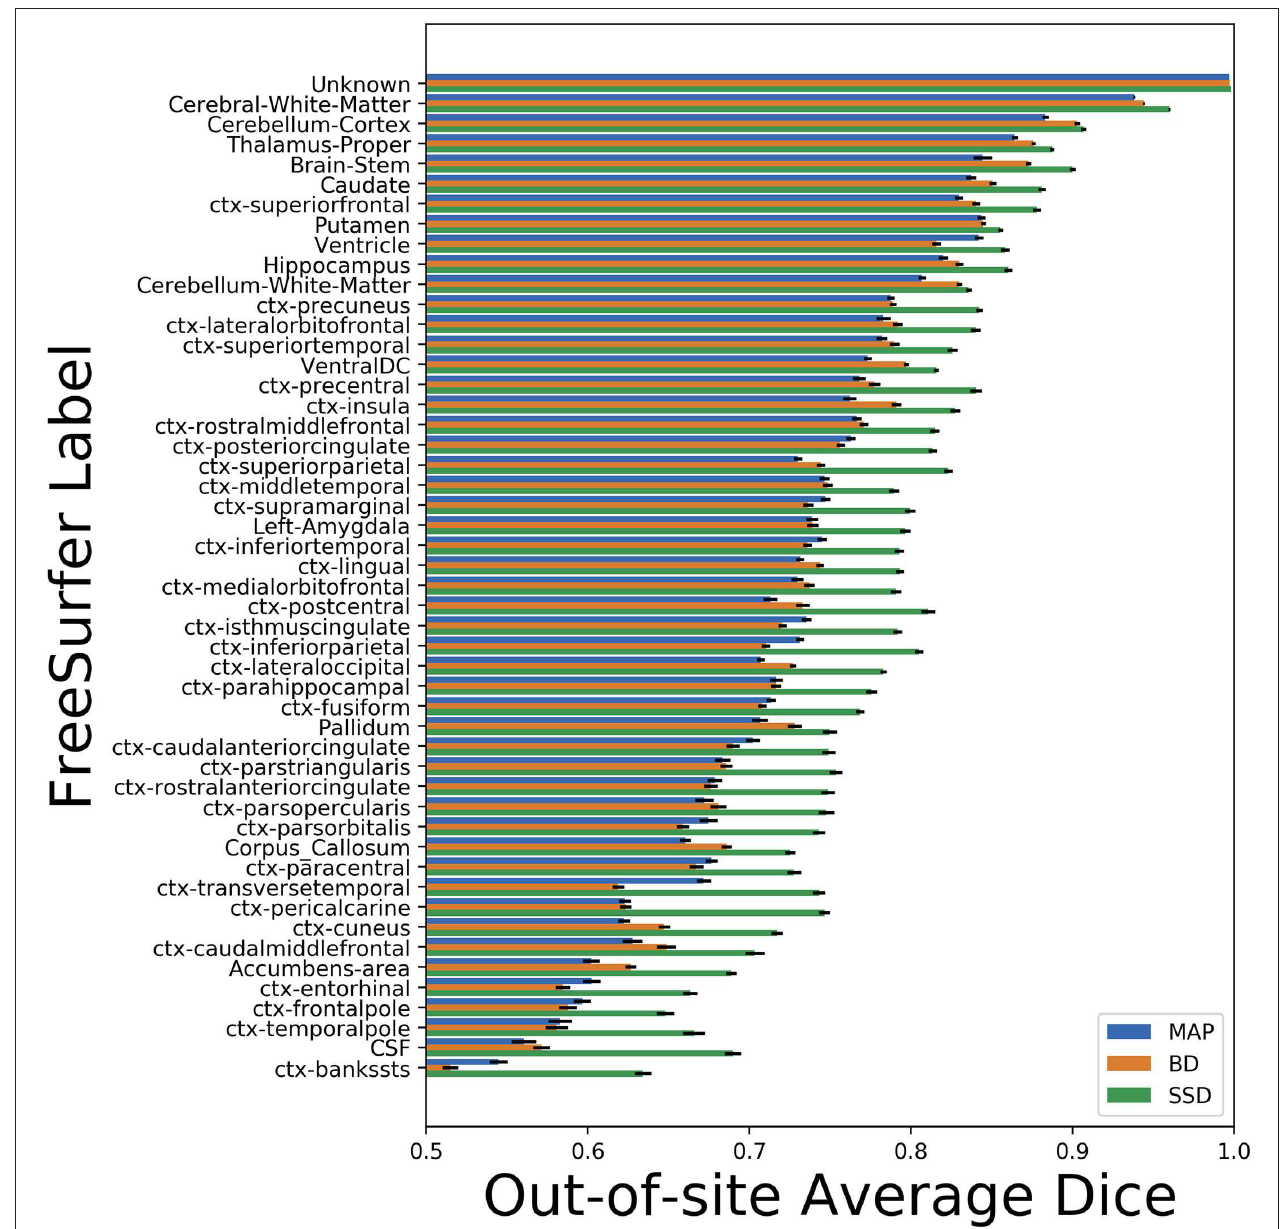
FIGURE 3 | Average Dice scores, sorted in decreasing order by average method performance, and standard errors across out-of-site test volumes for each label for the maximum a posteriori (MAP), MC Bernoulli dropout (BD), and spike-and-slab dropout (SSD)